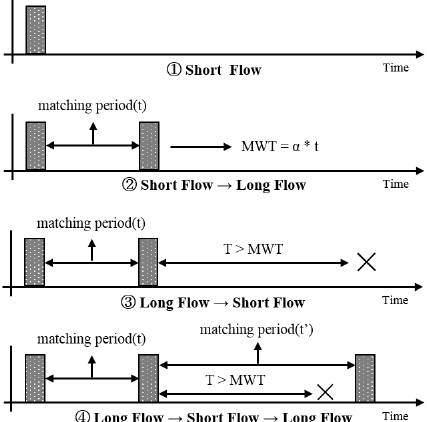
Figure 4. Flow identification in Short Flow First (SFF) scheme.